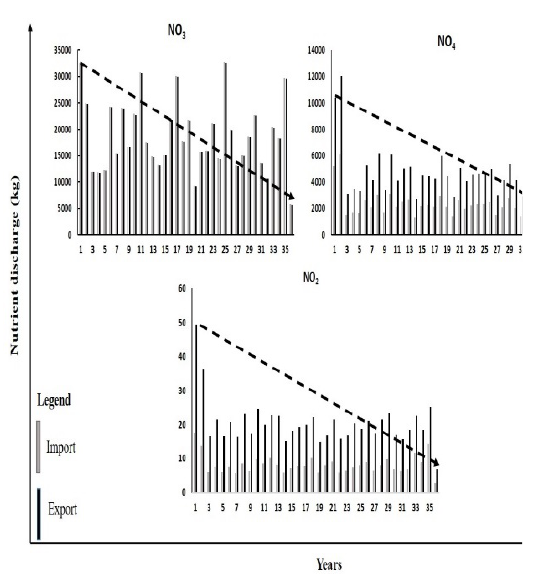
Figure 7. Discharge of soil nutrients (NO 3 , NH 4, NO 2 ) over observed period.